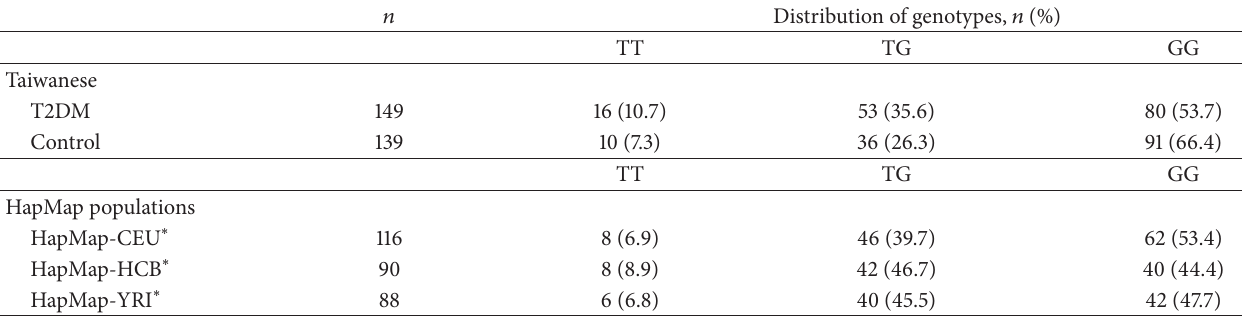
Table 6: ADIPOQ SNP rs1501299 genotype distribution in this study and HapMap. 𝑛 Distribution of genotypes, 𝑛